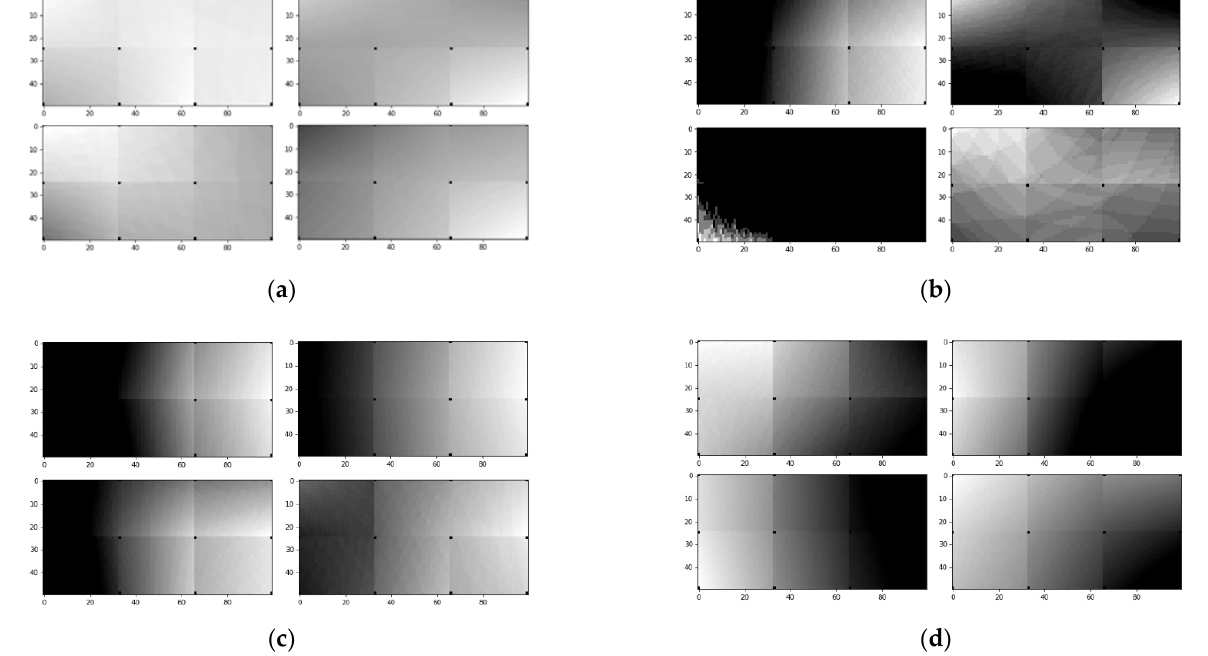
Figure 5. Part of the training set: ( a ) class none, ( b ) class both, ( c ) class top-left, ( d ) class bottom-right.